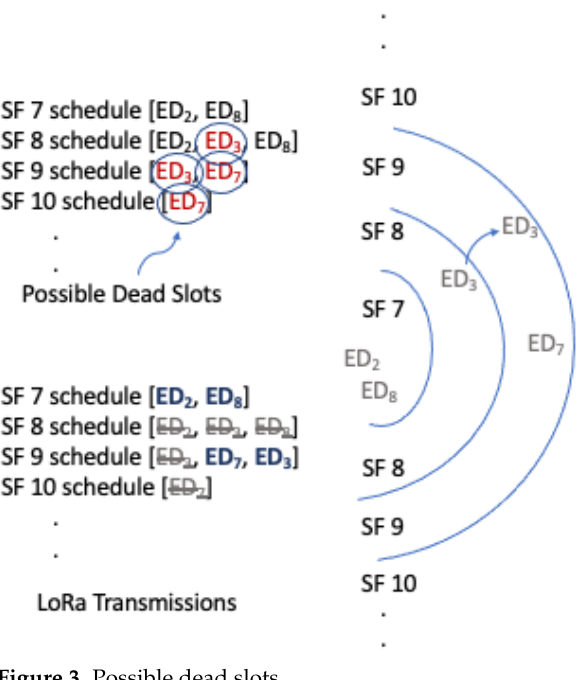
Figure 3. Possible dead